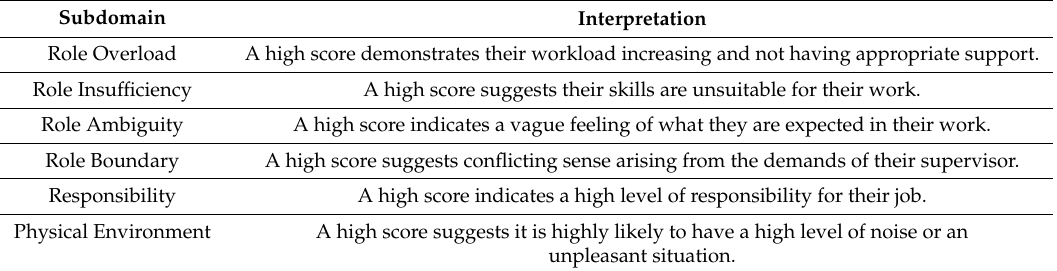
Table A1. Interpretation of the occupational role questionnaire